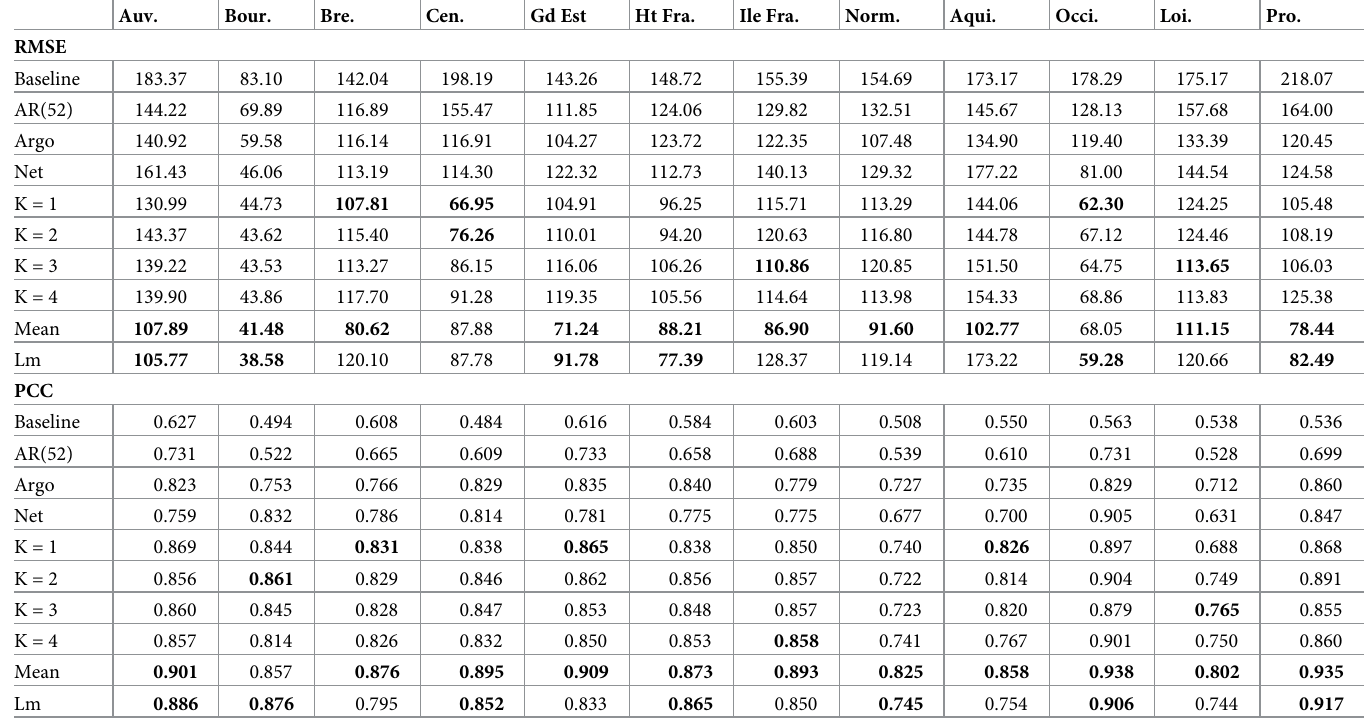
Table 14. PCC and RMSE for two-week ahead estimate for all french regions for the period starting from January 2015 to March 2017.